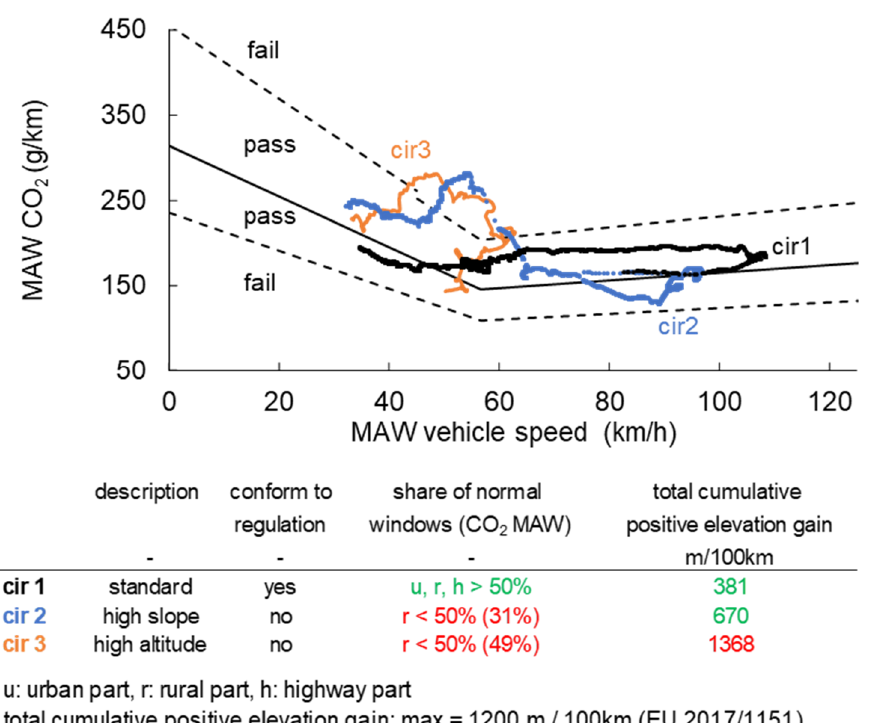
Figure 11. Influence of the varying altitude and slope on the trip validity, gasoline (V1).